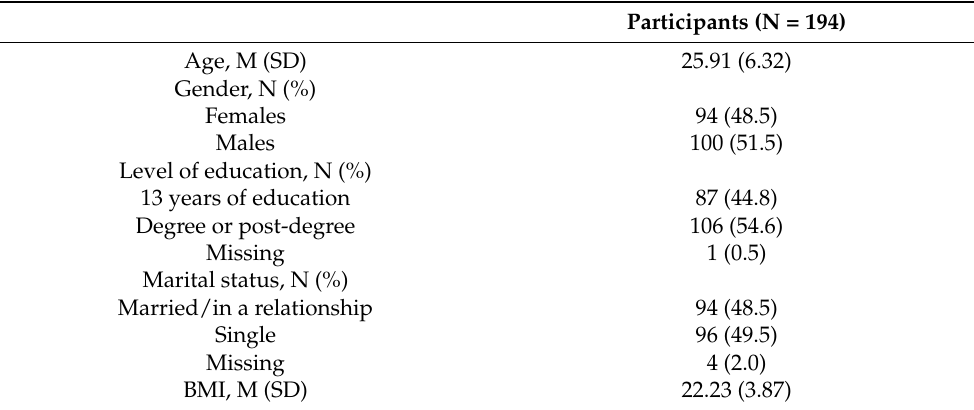
Table 1. Participants’ demographics and health-related